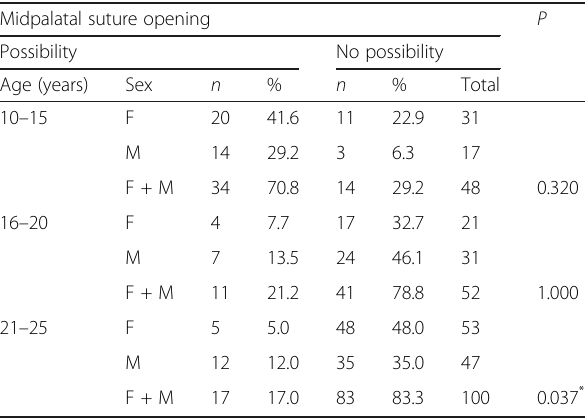
Table 2 Distribution of the MPS maturational stages by age group and sex regarding the possibility to find midpalatal suture opening Midpalatal suture opening